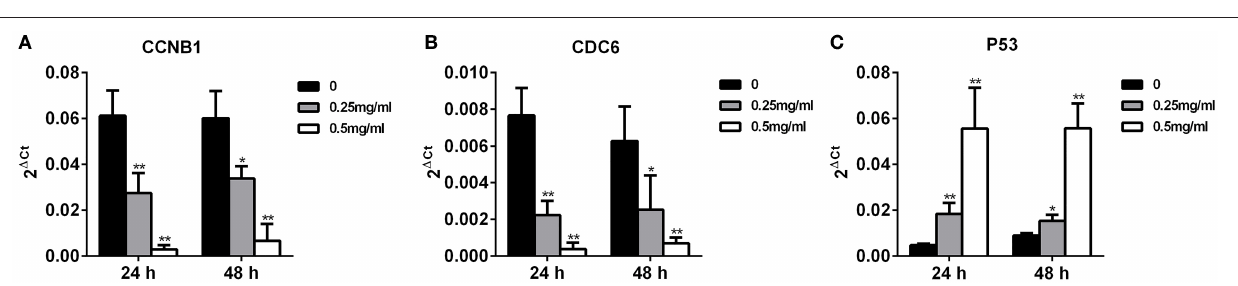
FIGURE 12 | Increased APS dose can effectively reduce the expression of CCNB1 and CDC6 and increase the expression of P53. MDA-MB-231 cell was treated for 24 or 48h with the indicated concentrations (0, 0.25, 0.5 mg/ml) of APS, levels of CCNB1 (A) , CDC6 (B) , and P53 (C) were determined using qRT-PCR. * p < 0.05, ** p < 0.01 vs. control (0